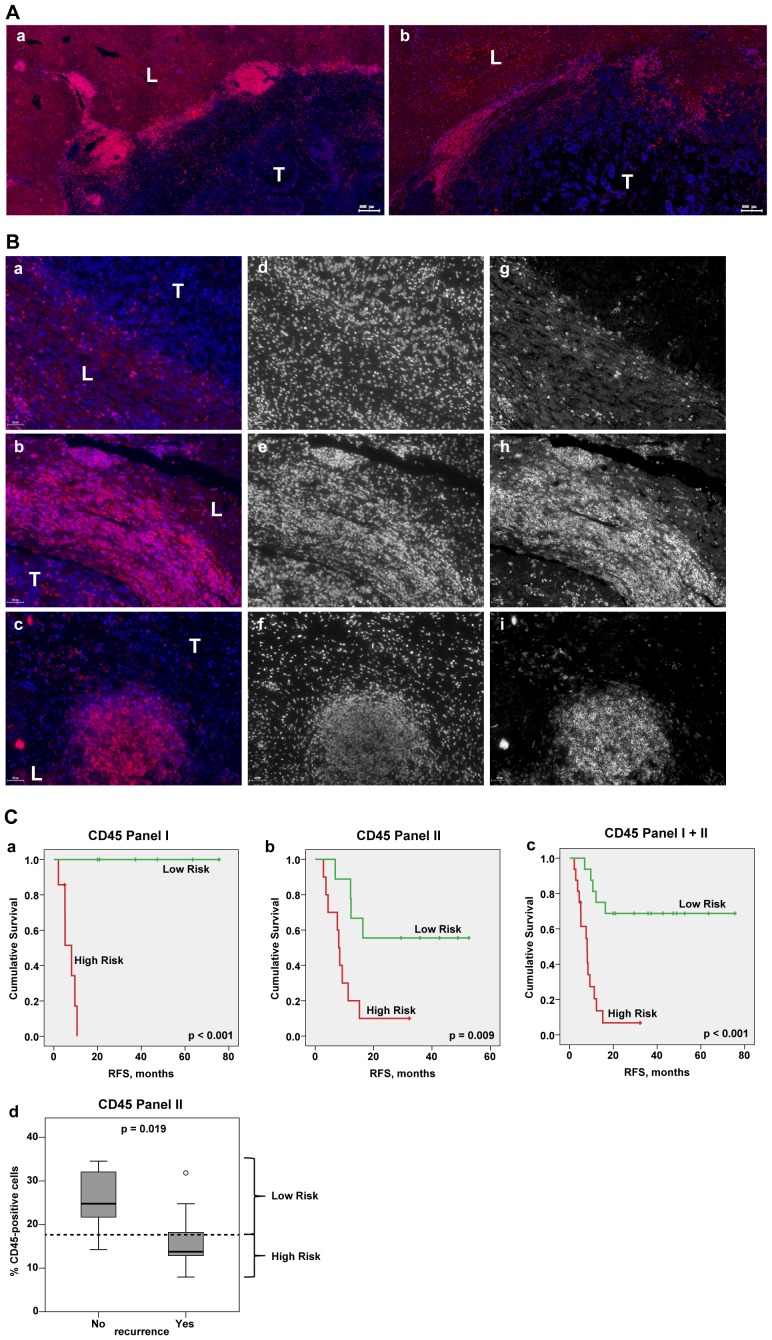
Patient-specific imprint of CD45-positive cells at the site of CRCLM.(A) Massive infiltration of CD45-positive cells confined to the tumor – liver border of the metastases. Representative parts of the metastatic areas for two CRCLM patients are shown (red channel for CD45, blue channel for nuclei/DAPI). T: tumor; L: liver. Scale bar: 200 µm. (B) Different patterns of CD45-positive cell accumulations at the metastatic border. Representative images of various types of immune cell infiltrates are shown: (a) single cells; (b) large immune cell aggregates; (c) prominent ectopic follicle. In addition to the merged images (a–c, red channel for CD45 and blue channel for DAPI), pictures of individual channels are included (d–f for DAPI; g–i for CD45); the individual channels are shown in black/white, whereas merged images are shown in color. T: tumor; L: liver. Scale bar: 50 µm. (C) (a–c) Kaplan-Meier estimates for patients stratification based on the CD45-derived values at the border. Kaplan-Meier curves for RFS based on CD45 values for panel I, panel II, and their combination are shown giving patients' stratification into low and high risk groups (higher than median indicates low risk); p value of the log-rank test is indicated. Panel I: median is equal to 20.95, below median n = 6, above median n = 7; panel II: median is equal to 17.66, below median n = 10, above median n = 9; panel I+II: median is equal to 19.13, below median n = 16, above median n = 16. (d) Boxplots of CD45 data sets for patients without recurrence (No) versus patients with recurrence (Yes) at the time point of 17 months. The cut off was set according to the latest event occurrence (16.3 months) where no censoring has occurred, thereby, providing clear separation from the censored subjects (≥32.2 months) as visualized on (b). The median CD45 value, which was used for patient stratification into low and high risk groups on the Kaplan-Meier plot (b) is indicated by dashed line; p value is shown (t test).